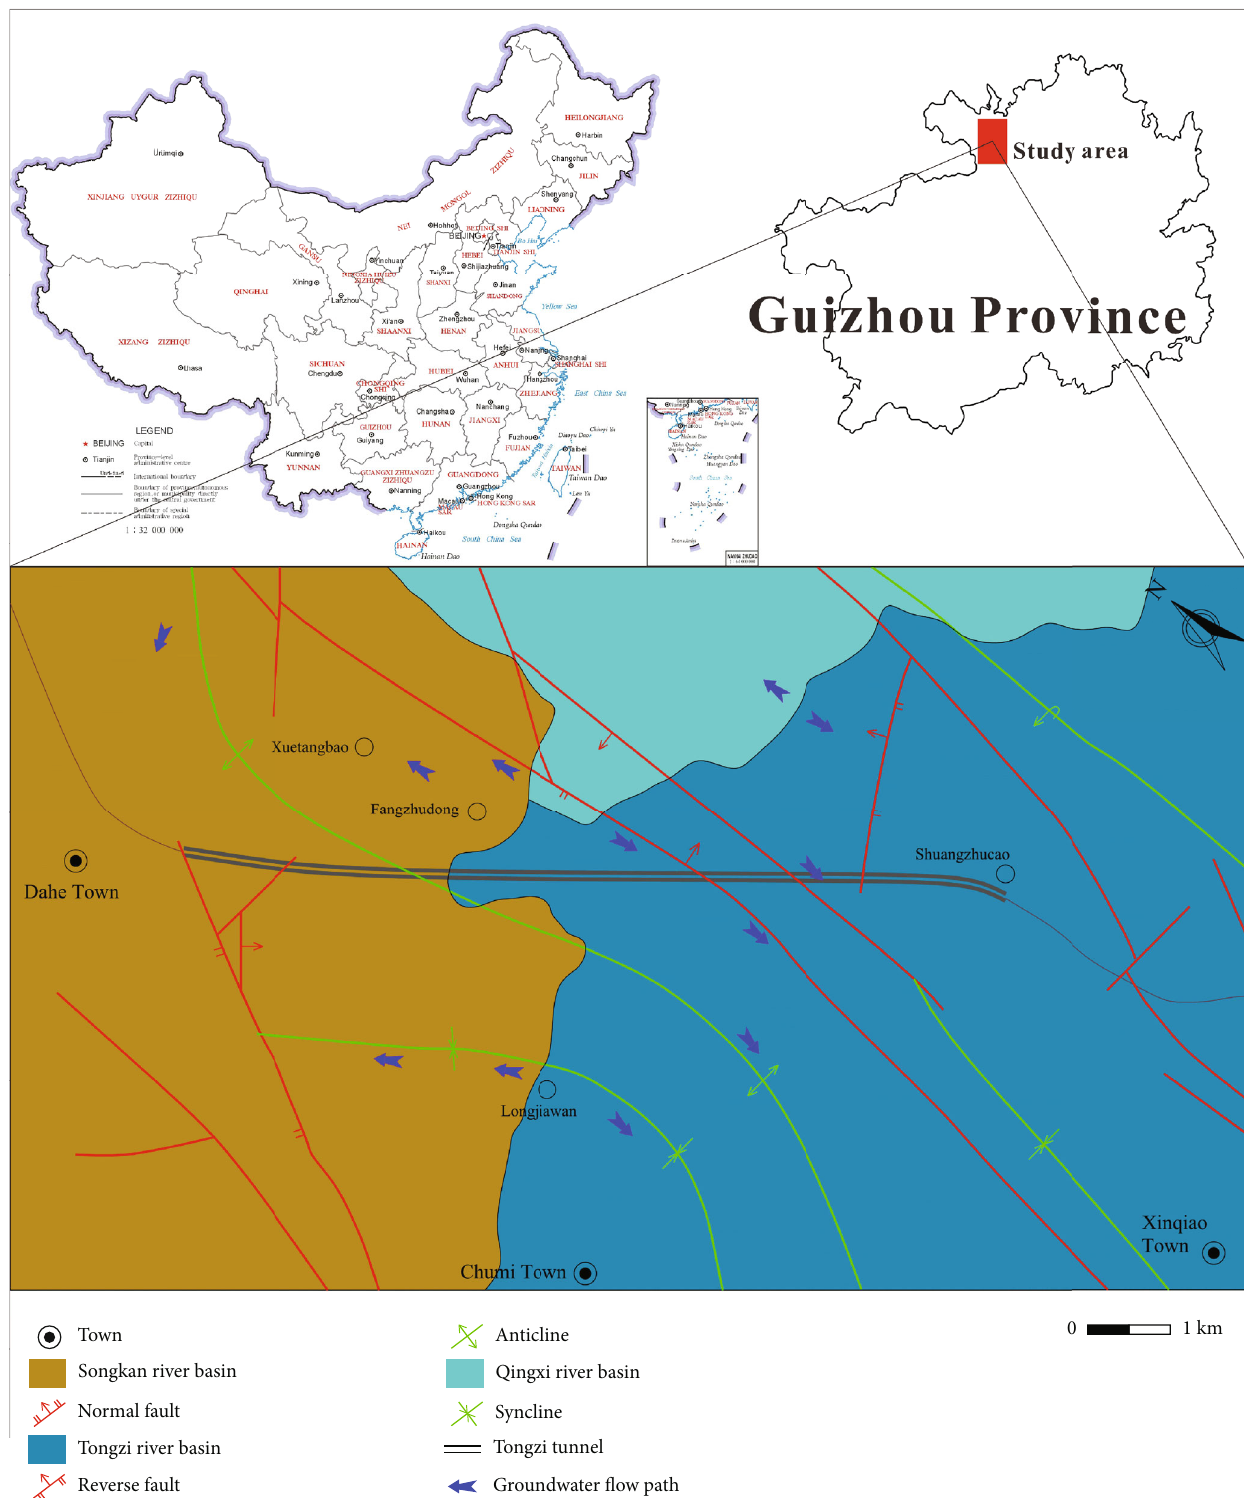
Figure 1: Location and overview of the study area (China map from Ministry of Natural Resources Standard Map